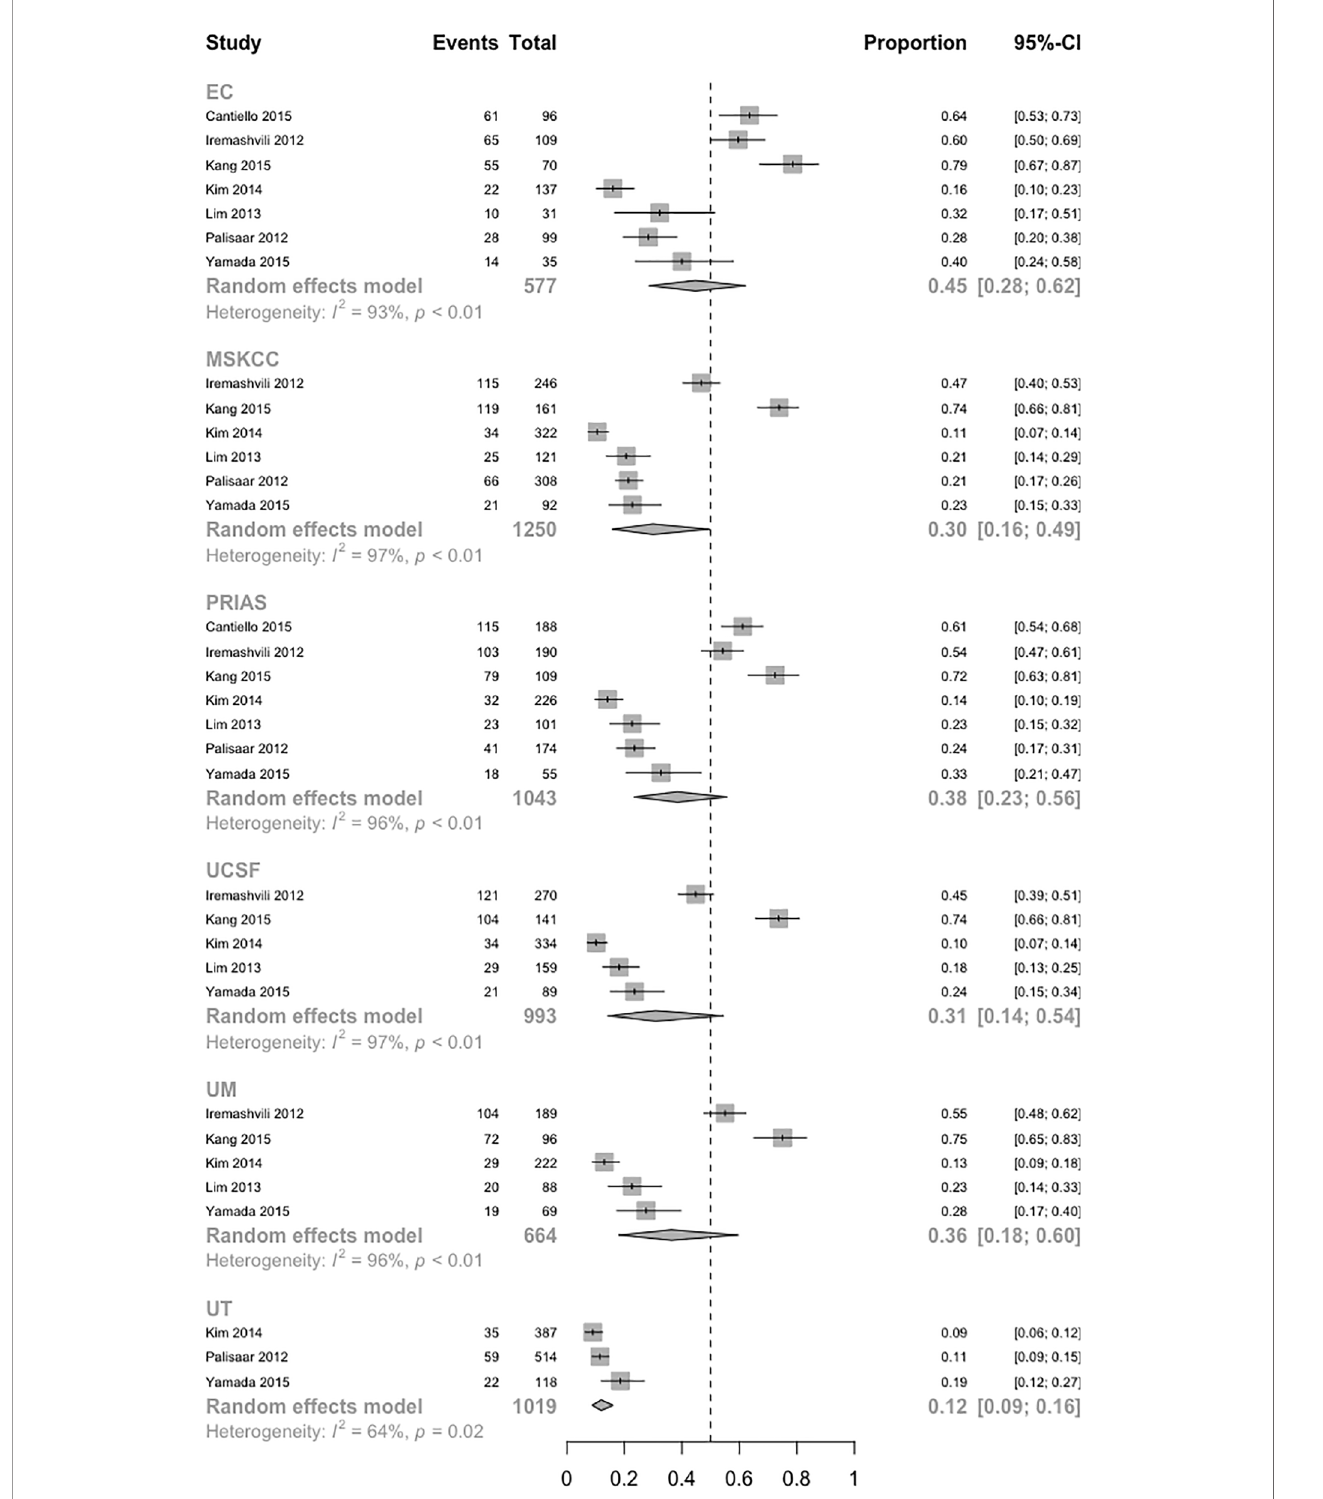
FIGURE 3 | Population-weighted pooled diagnostic accuracy of each AS protocol. (InsigPCa1, including 6 studies with classical de fi nition and 1 study with updated de fi nition of insigPCa). Note: The absolute diagnostic accuracy of the Yonsei protocol was calculated based on only Lim et al, which was 0.25.